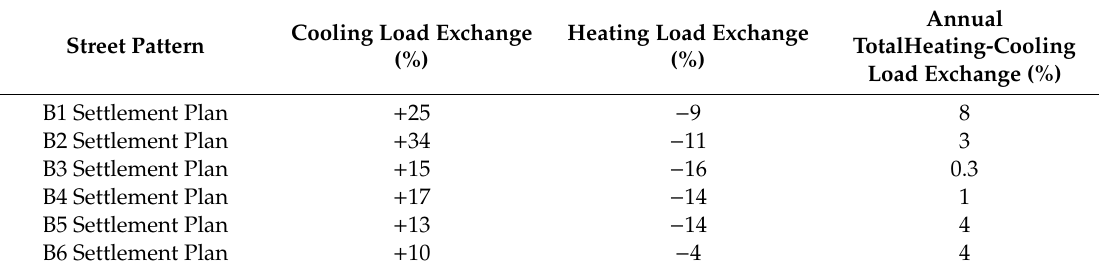
Table9. Annualenergygain-losspercentagechangesduetoshadowe ff ectofdi ff erentsettlementlayouts.